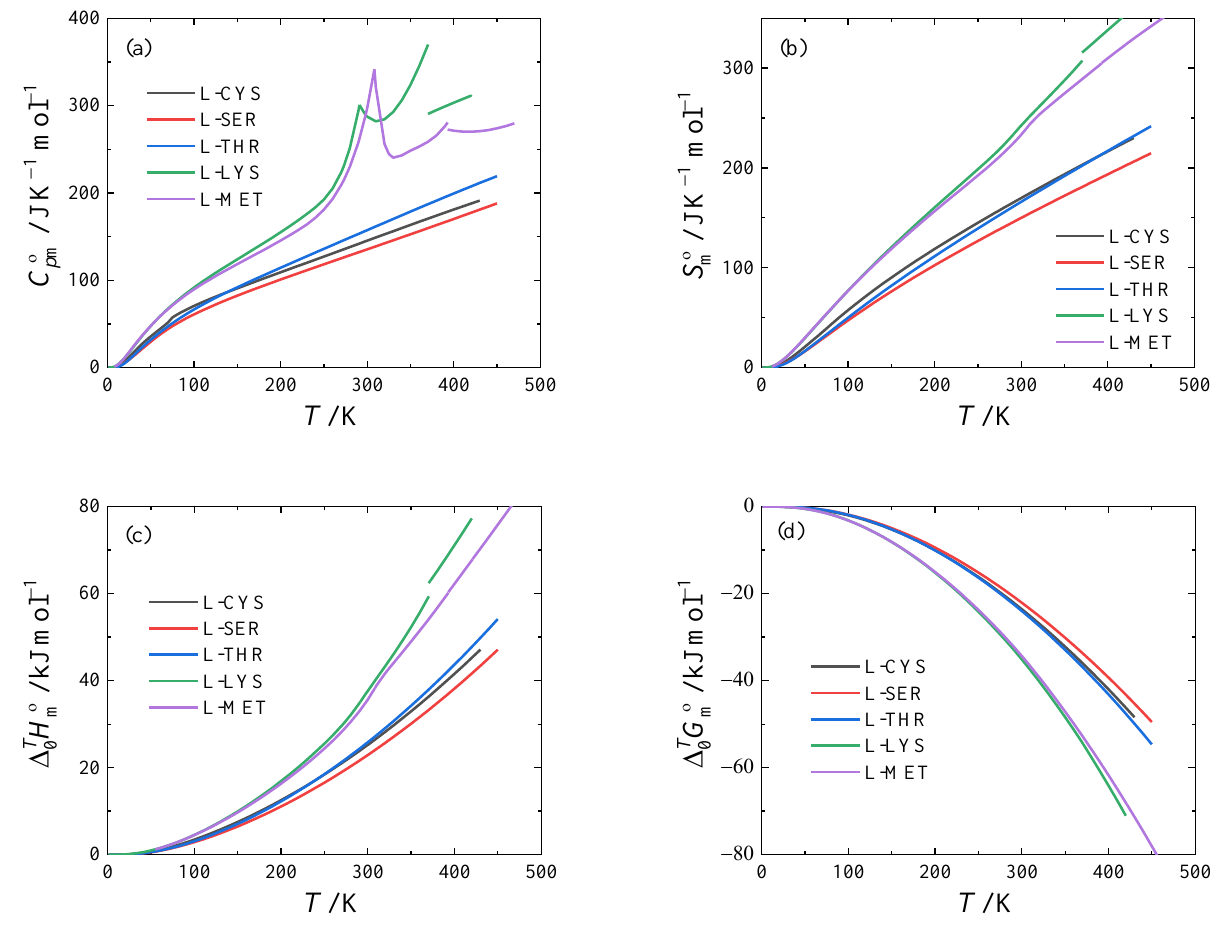
Figure 4. Standard molar thermodynamic functions of stable forms at p = 0.1 MPa. ( a ) isobaric heat capacity, ( b ) entropy, ( c ) enthalpy, and ( d ) Gibbs energy.